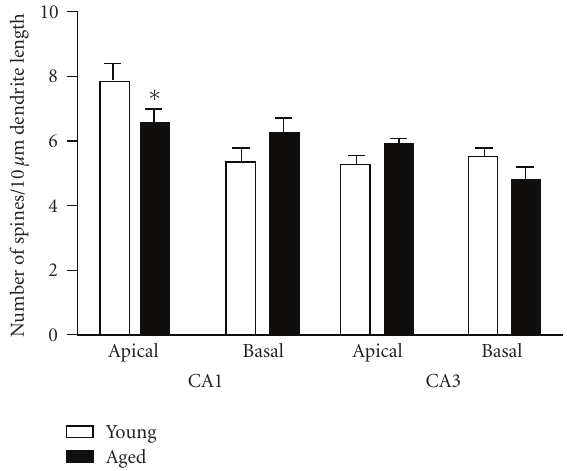
Figure 3: Spine density. Columns are the mean number of spines/ 10 μ m of dendrite length ± SEM. Data analyzed by two-way ANOVA, group (young, aged) × field (CA1 apical, CA1 basal, CA3 apical,CA3 basal).A significante ff ect offield, F (3,60) = 14 . 24, P < 0 . 000, and a significant group × field interaction, F (3,60) = 3 . 35, P < 0 . 009, was found. Post hoc di ff erences between young and aged fields were tested by t -test, ∗ P < 0 . 049.